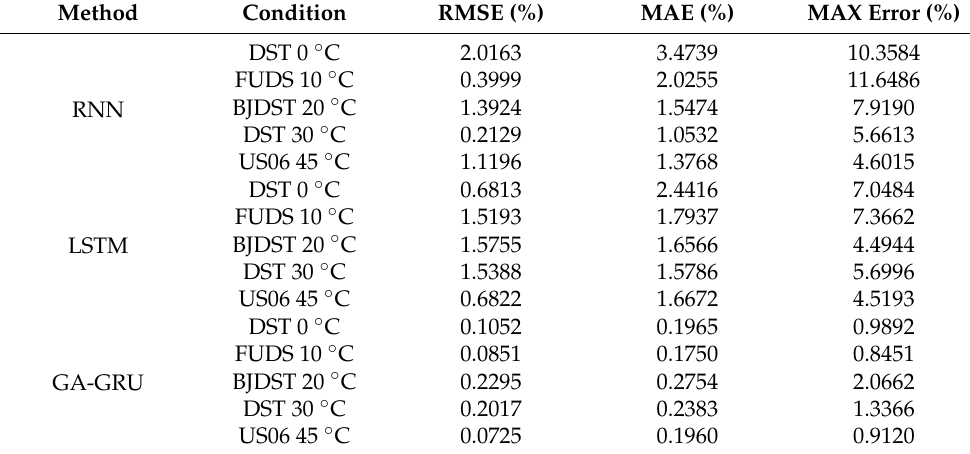
Table 3. Comparison of SOC estimation numerical results under different driving conditions.